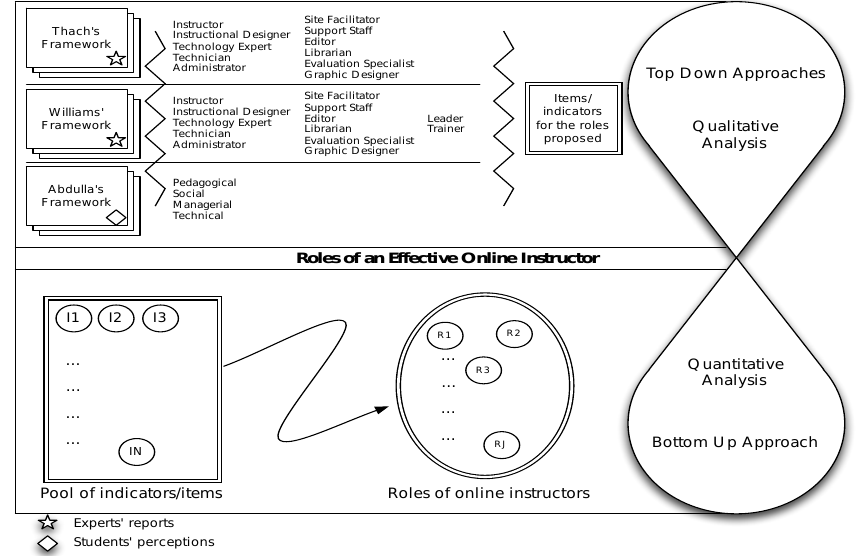
Figure 1. Methodological framework proposed for identifying the roles of online instructors (N represents the total number of indicators and J the number of